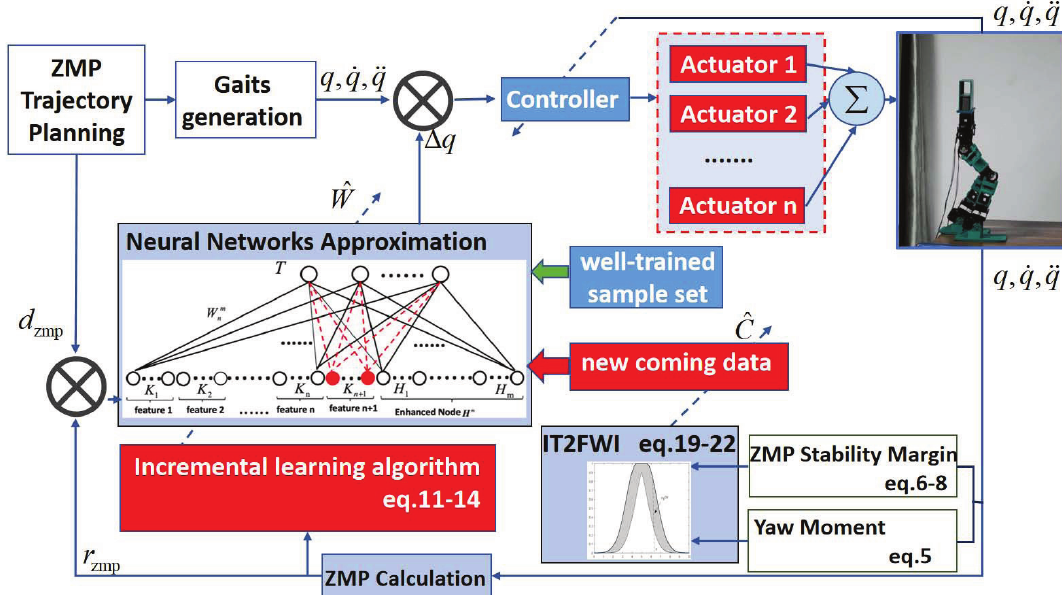
Figure 3. Architecture of proposed control system for biped